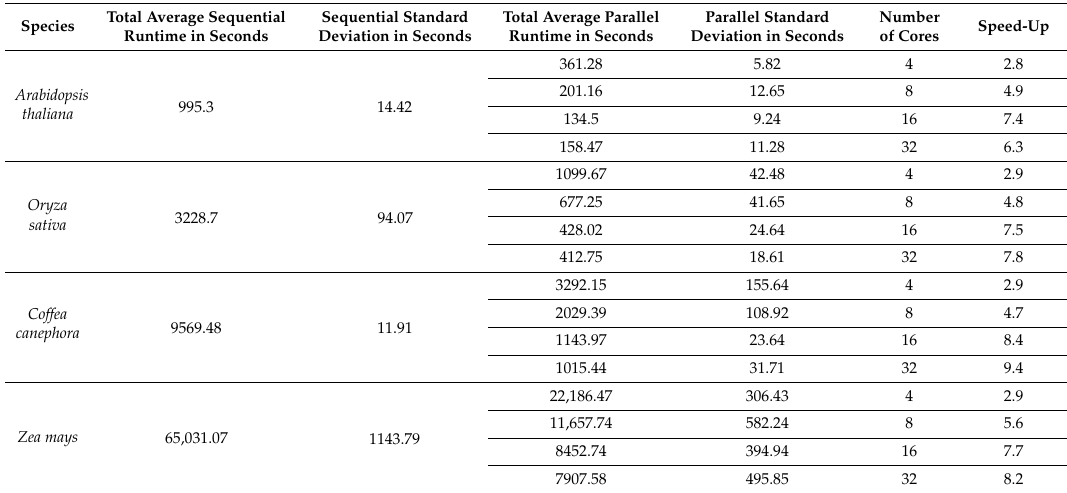
Table 1. Results of Inpactor on 4 different plant